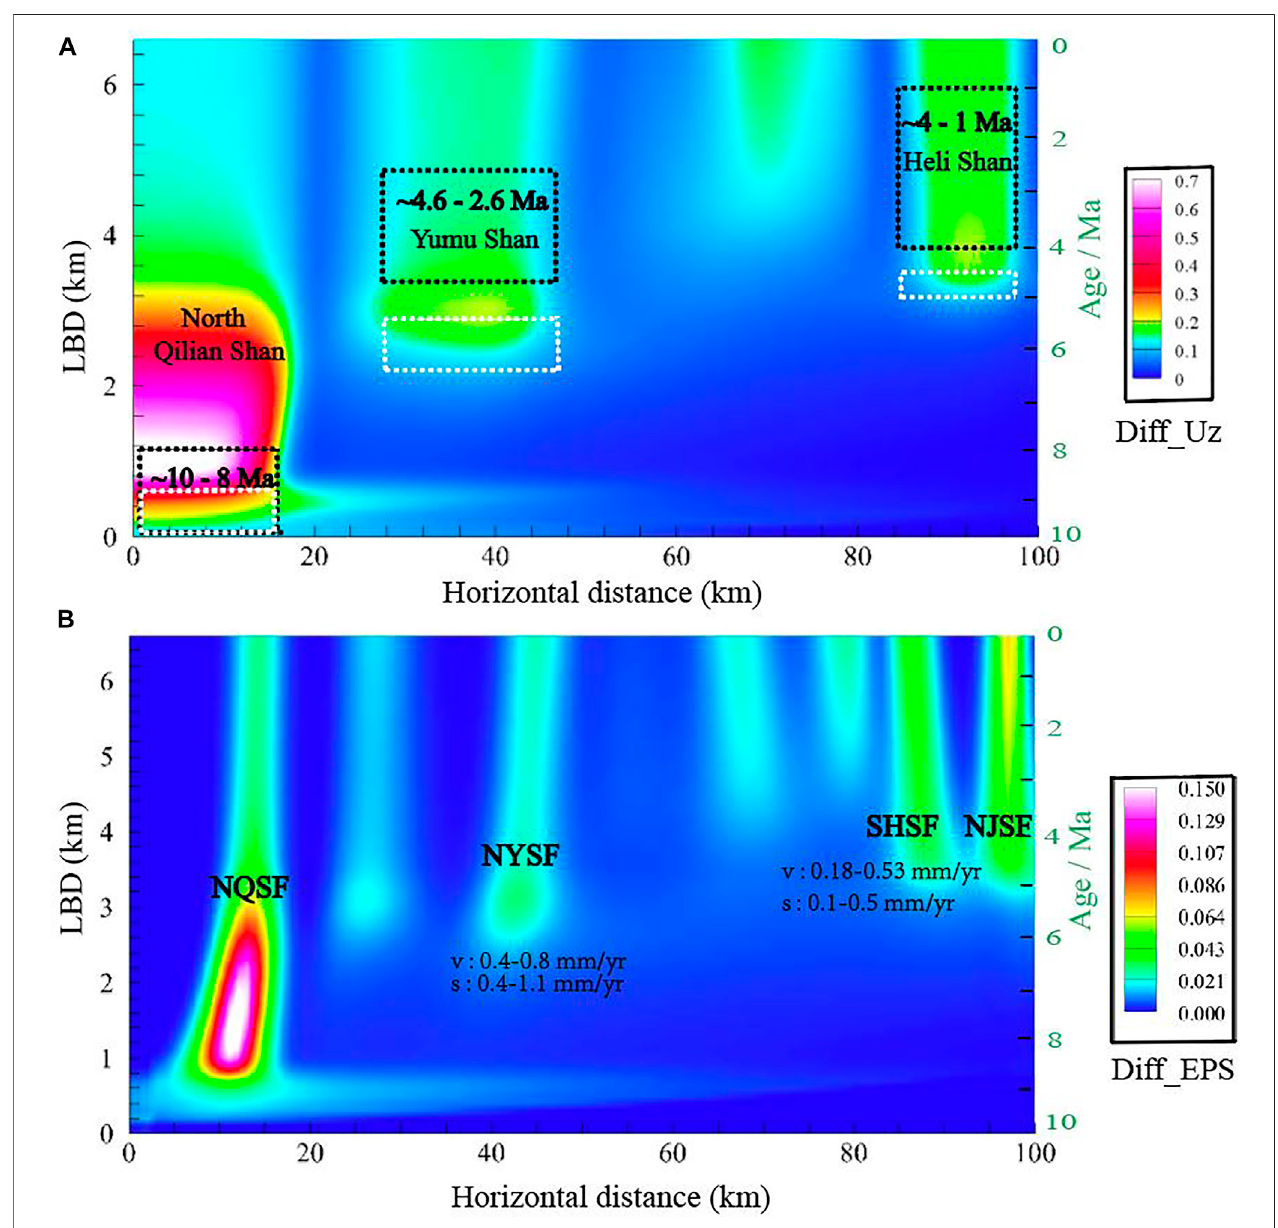
FIGURE 5 | Differentiation (rate) of two model output variables on upper surface, with respect to LBD increments (related to time increments). Finite differences (derivatives numerators) are not divided by denominator increments (of LBD or time). Panels show upper surface. (A) Differential of vertical displacement Uz and (B) Differential of EPS; as functions of horizontal distance, as they evolve with progressing LBD (which might be related to a geologic timescale, here set to last 10 Ma as a plausible relevant example). Highest “ rates ” of change of uplift and plasticity clearly manifest over x < 20 km. Annotations on both panels are interpreted features, highlycorrelatedwithreal-Earthobservedranges (A) andfaults (B) .Inpanel (A) ,superimposedaredashed-linerectanglesofobserved(black)andmodeled(white)uplift- onset time intervals, which should correspond to accelerating stages. In model, after respective onset-and-maxima times, uplift rates and plasticity rates continue being non-zero (positive), consistent with present-day continued ranges uplift and bounding-faults activity.